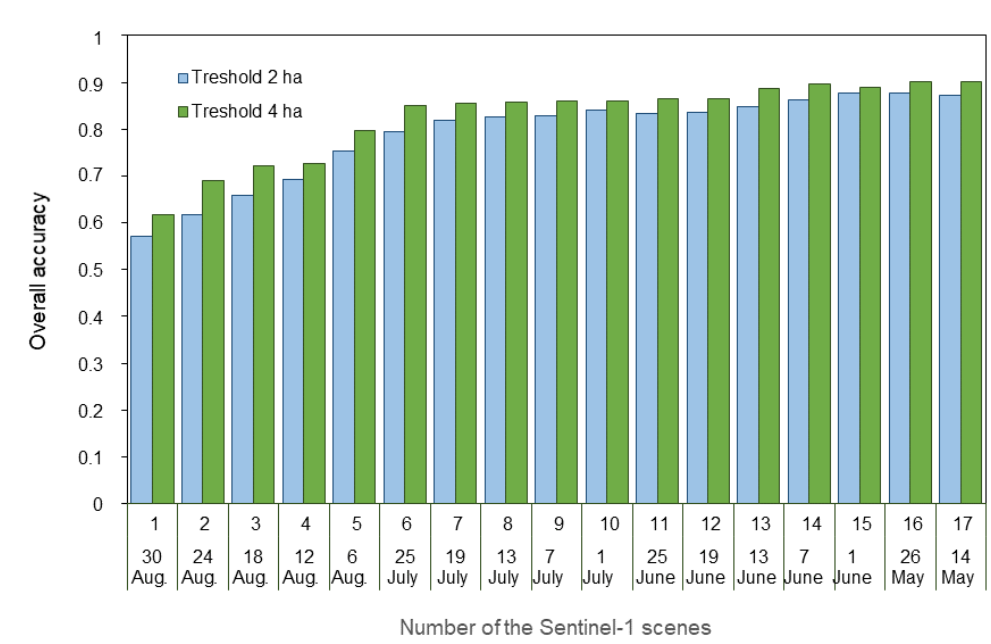
Figure 5. Overall accuracies as a function of the stage of the phenology and the number of scenes calculated with the minimum sizes of the parcels of two and four hectares. The time is reverse compared to Figure 4.